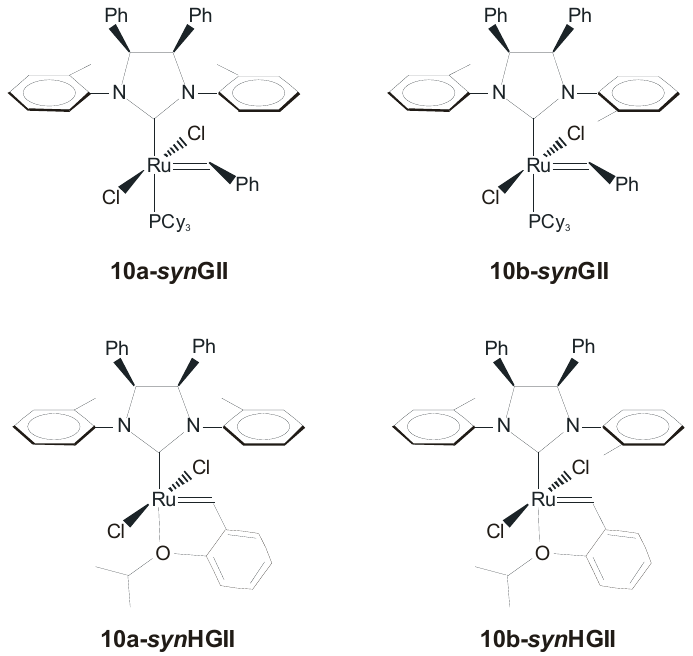
Figure 8. Catalysts with syn phenyl groups on the NHC backbone.